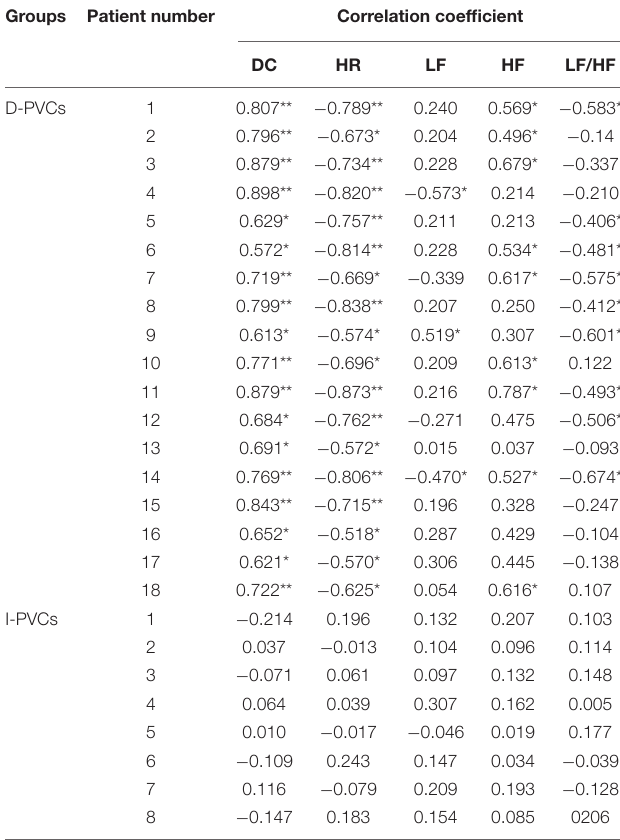
TABLE 2 | Correlations between hourly PVCs burden and hourly DC, HR, and HRV in each patient.